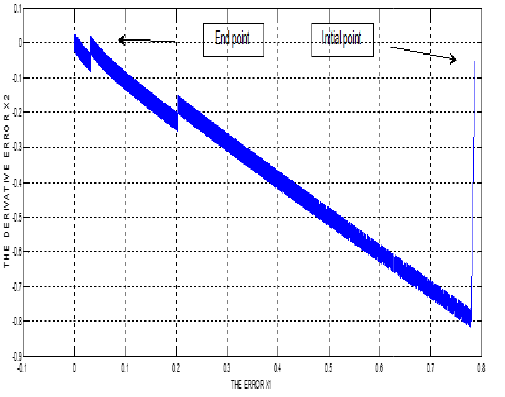
Fig. 11. The plot of the phase plane between _ b of the classical SMC.